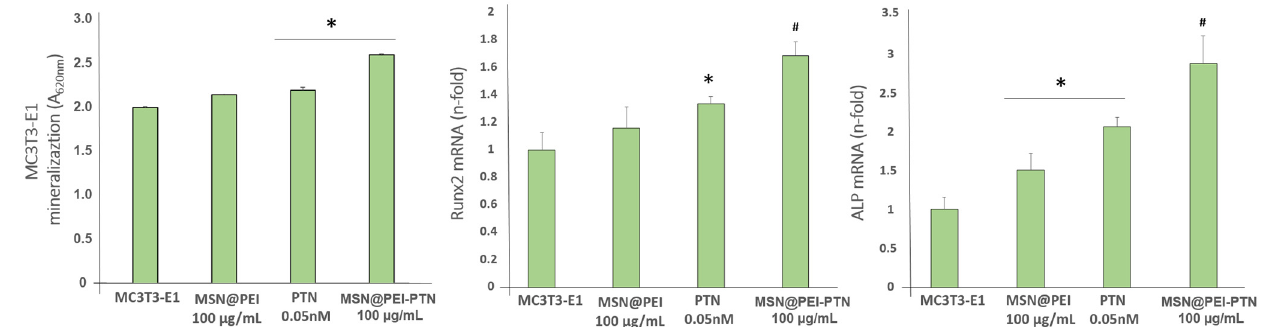
Figure 5. Mineralization and changes in osteoblastic gene expression in mouse pre-osteoblastic MC3T3-E1 cells induced by different nanosystems loaded or not with pleiotrophin (PTN) or in the presence of 0.05 nM exogenous PTN alone. Mineralization was assessed using alizarin-red staining at day 15. The gene expression of Runx2 and ALP markers (analyzed by real time PCR) was measured at day 5. Data are mean ± SEM of three independent experiments performed in triplicate. * p < 0.05 vs. MSN 100 μ g/mL; # p < 0.01 vs. PTN 0.05 nM and all groups.